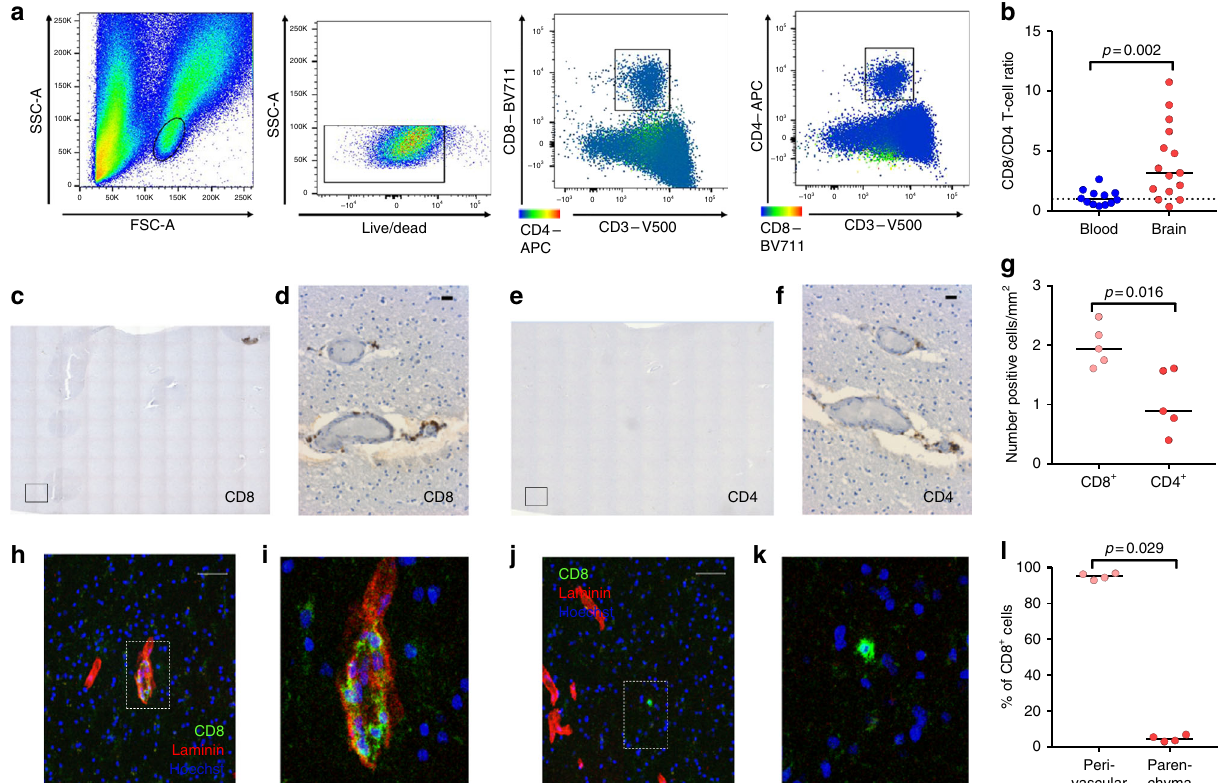
Fig. 1 CD8 + and CD4 + T cells populate the human brain. a Gating procedure applied to analyze brain CD3 + CD4 + and CD3 + CD8 + T cells, eluted from normal-appearing white matter. b Quanti fi cation of the CD8 + /CD4 + T-cell ratio. Immunohistochemical staining of CD8- ( c , d ) and CD4- ( e , f ) immunoreactive cells in normal subcortical white matter of a donor without brain disease. c , e Overview of 10 × 10 tiled images at 10× magni fi cation; the marked square indicates a bright fi eld. d , f 20× magni fi cation (scale bar = 20 µ m). g Quanti fi cation of CD8-immunoreactive and CD4-immunoreactive cells (number/mm 2 ). h – k Immuno fl uorescent staining of CD8 (green), laminin (red), and Hoechst (blue) at 10× magni fi cation (scale bar = 50 µ m) ( h , j ) and a zoom-in ( i , k ). l Quanti fi cation of CD8-immunoreactive cells co-localizing with laminin (perivascular space) or not co-localizing with laminin (parenchyma). Bars show median values. p -values show Mann – Whitney U